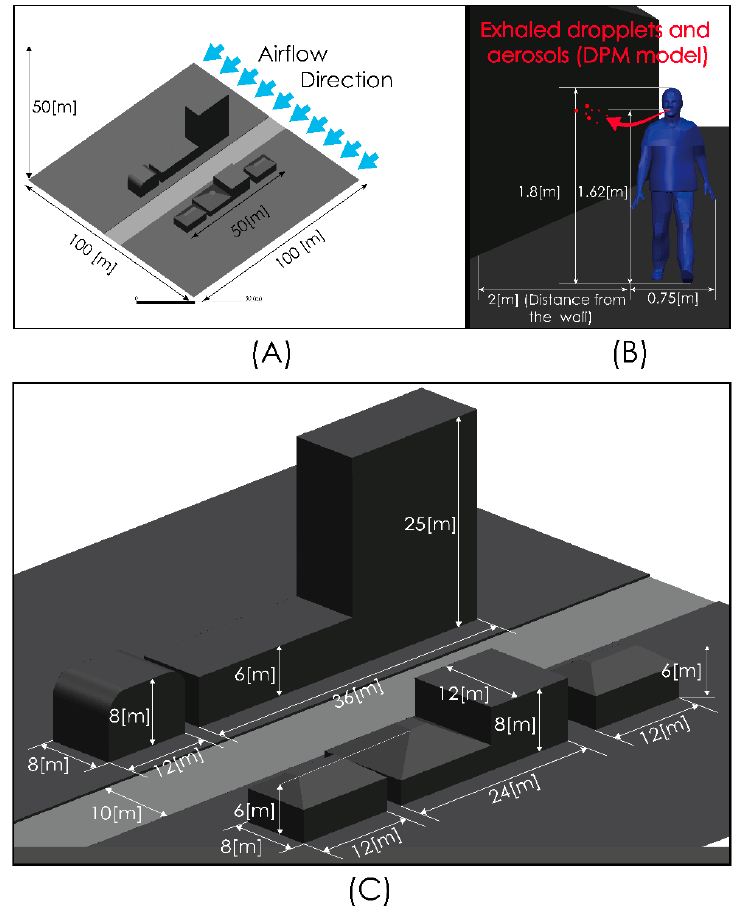
Figure 2. Computational model dimensions. Global views ( A , C ) and near person zone ( B ).